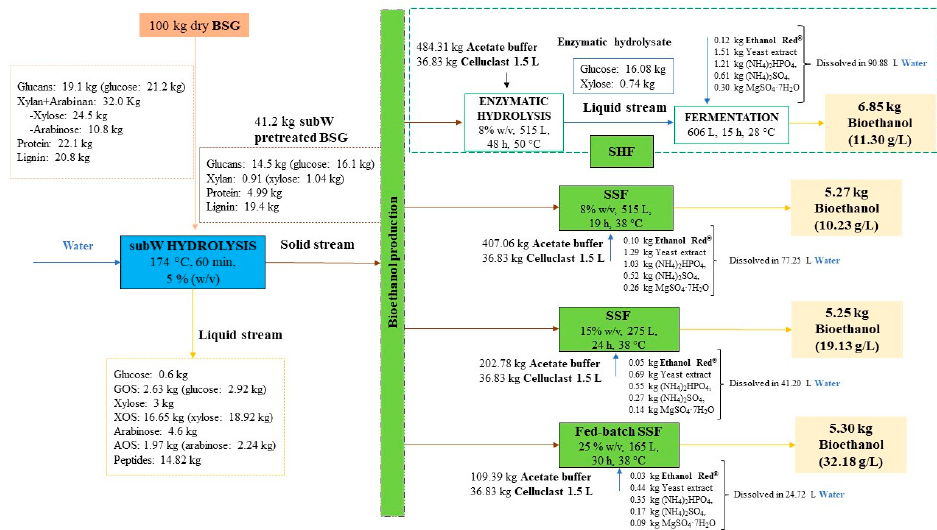
Figure 8. Diagram flow for bioethanol production from subW-pretreated BSG by saccharification and fermentation at different operational modes. “GOS”,” XOS”, and “AOS” stands for gluco-oligomers, xylo-oligomers, and arabino-oligomers, respectively. Calculation has been conducted considering no solvent retention. Table 4. Mass balance (MB) of subW hydrolysis at 5% ( w / v ) and subsequent enzymatic hydrolysis at 8% ( w/v ) solids loading from 100 kg of dry BSG. Mass of each compound in feed (m feed ), subcritical